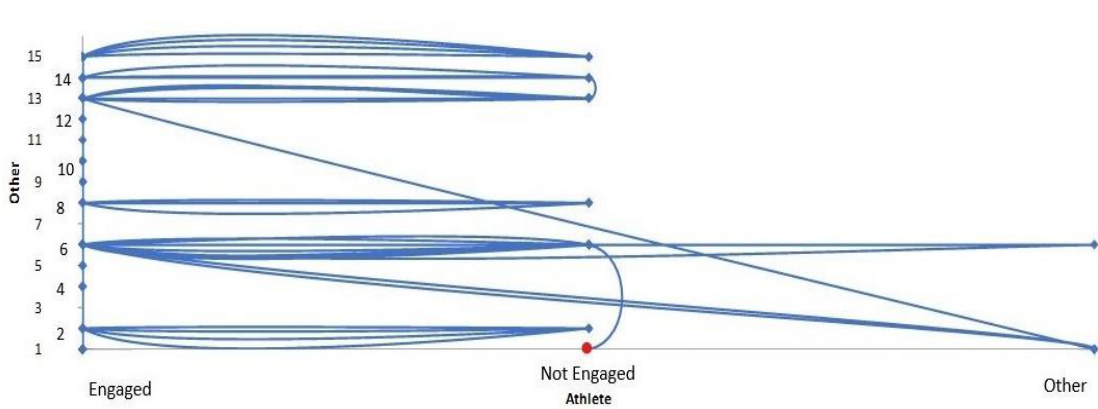
Figure 1. Behavioural sequence of the male curling athlete comparing engagement and communication behaviours. ‘Other’ behaviours indicate when the video was not otherwise coded such as walking off screen. The circle indicates the commencement of behavioural sequence. Note. 1 – Other (Athlete); 2 – Modeling (Peer); 3 – Modeling (Coach); 4 – Activity Communication (Athlete); 5 – Activity Communication (Peer); 6 – Activity Communication (Coach); 7 – Activity Feedback (Athlete); 8 – Activity Feedback (Peer); 9 – Activity Feedback (Coach); 10 – General Feedback (Athlete); 11 – General Feedback (Peer); 12 – General Feedback (Coach); 13 – General Communication (Athlete); 14 – General Communication (Peer); 15 – General Communication